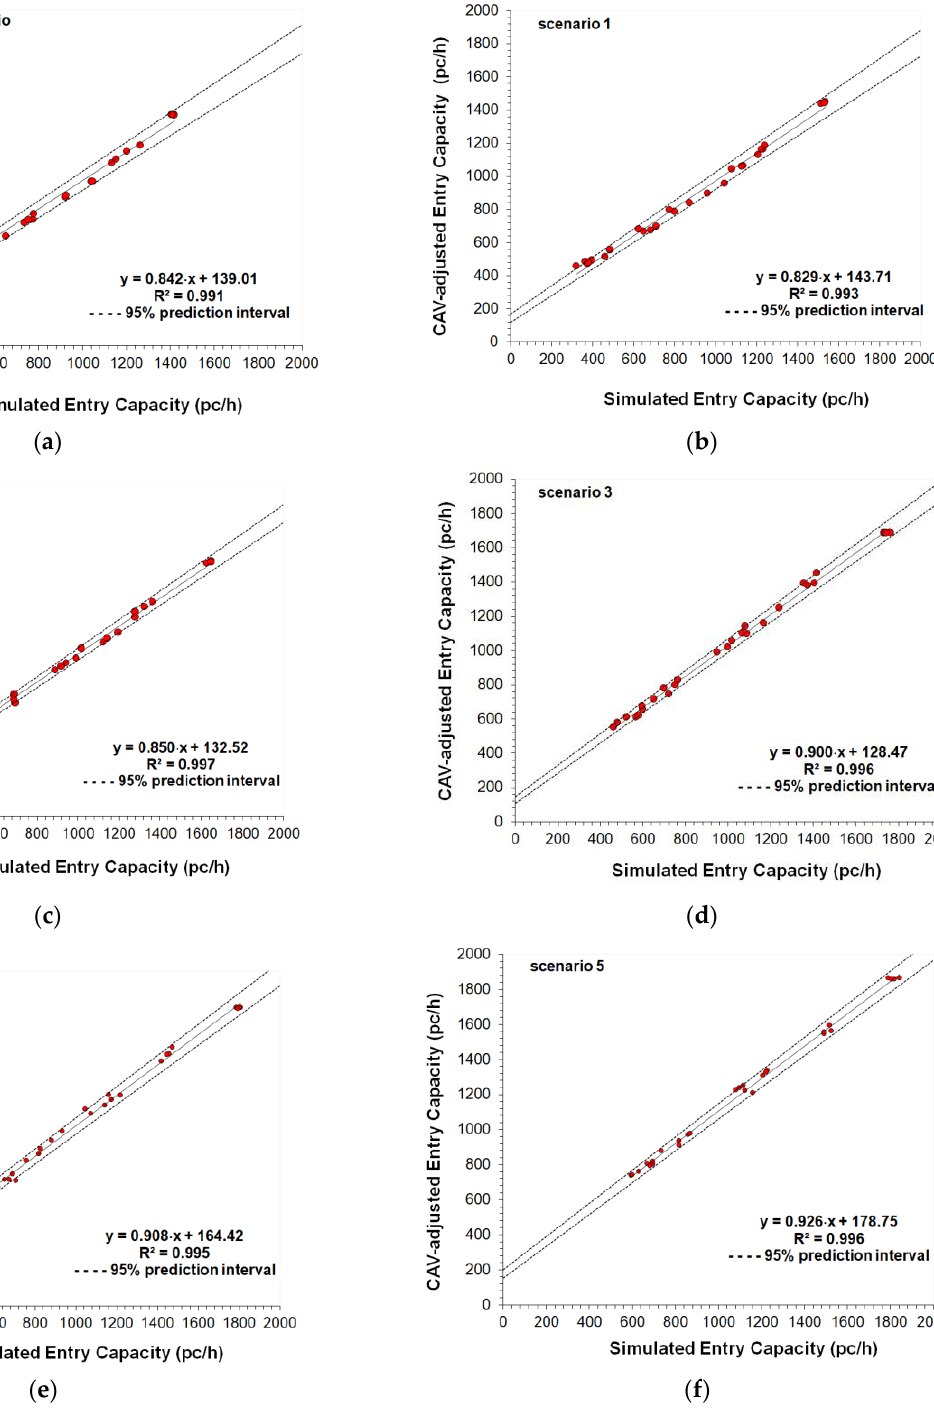
Figure 6. Scattergram analysis to compare the CAV-adjusted and simulated entry capacity data for different proportion of CAVs and HDVs for the entry mechanism 1 (i.e., one-lane entry conflicted by one circulating lane) listed as: ( a ) baseline scenario: 0% CAVs and 100% HDVs; ( b ) scenario 1: 20% CAVs and 80% HDVs; ( c ) scenario 2: 40% CAVs and 60% HVs; ( d ) scenario 3: 60% CAVs and 40% HDVs; ( e ) scenario 4: 80% CAVs and 20% HDVs; ( f ) scenario 5: 100% CAVs and 0% HDVs. Note: